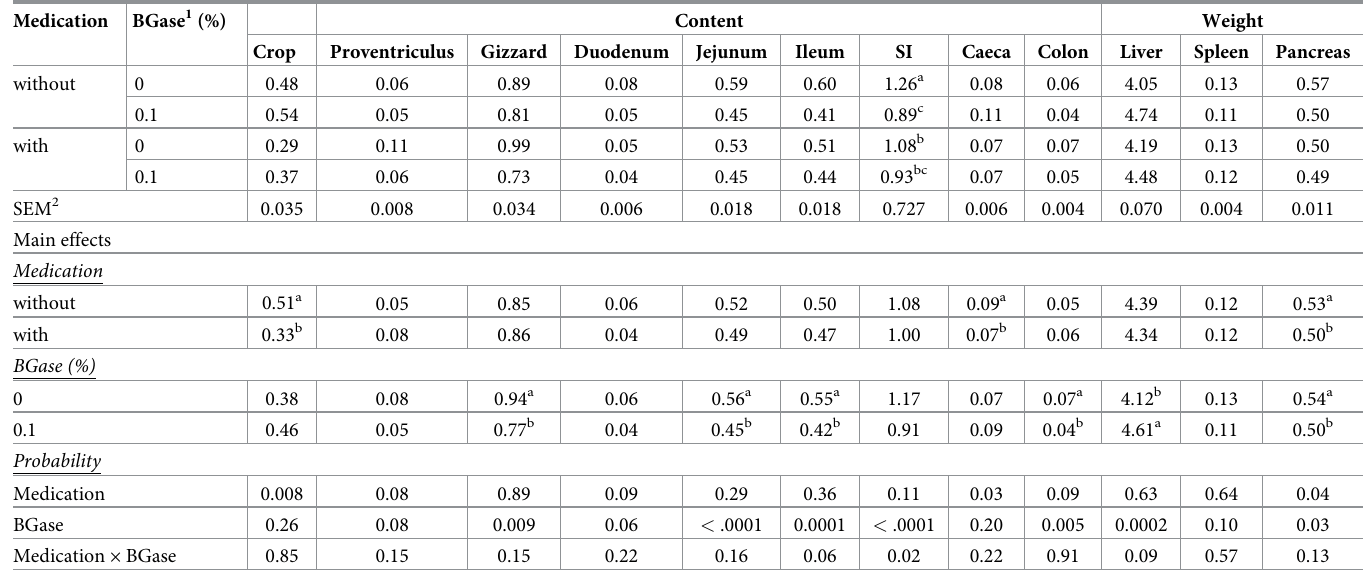
Table 18. Effects of diet medication and β -glucanase on gastro-intestinal content and organ weights as a percentage of body weight of broiler chickens at day 11 (Experiment